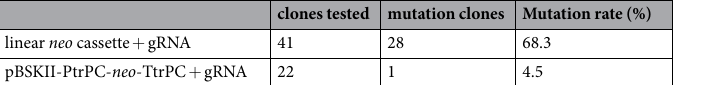
Table 1. Comparison of the mutation rate in transformates generated by linear neo cassette and circular